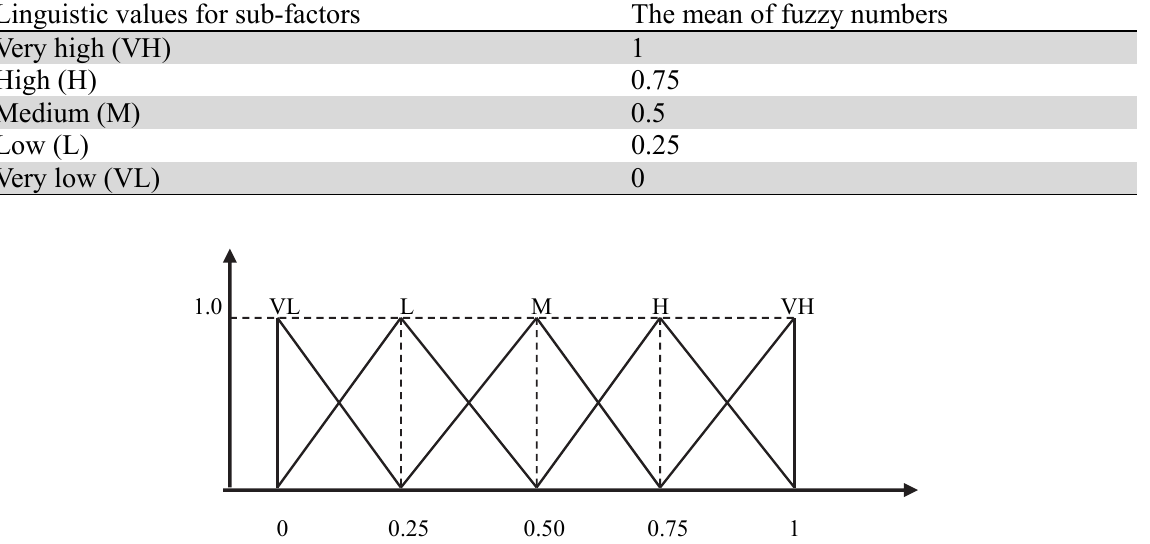
Fig. 5. Membership functions of linguistic values for sub-factor rating (Dagdeviren & Yüksel, 2010).